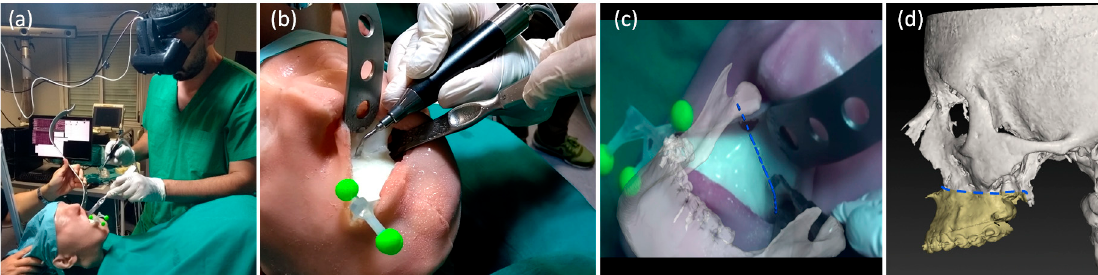
Figure 5. Execution of Le Fort 1 osteotomy under VOSTARS guidance ( a , b ), i.e., following the displayed virtual osteotomy line ( c ) derived by preoperative surgical planning ( d ).